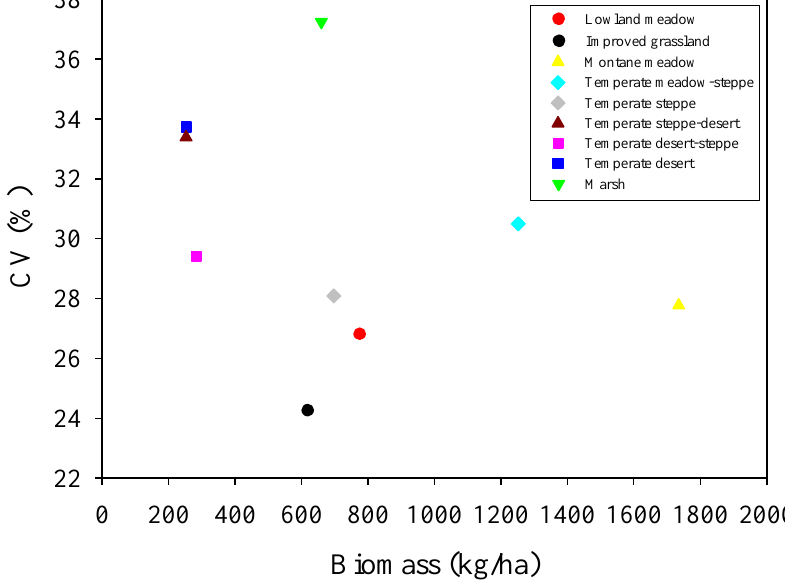
Figure 7. Biomass-CV plot for different grassland types. Biomass was calculated as the 7-year-average grassland biomass in different grassland types. CV was calculated from the annual biomass of grassland types from 2006 to